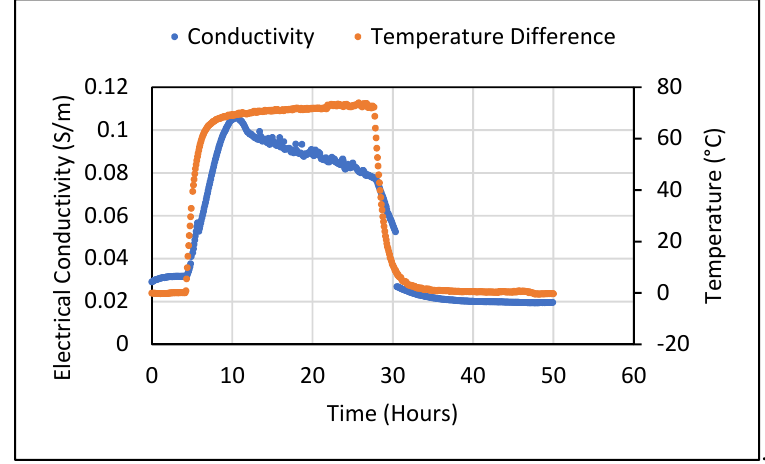
Figure 16. Electrical conductivity at elevated temperature for 5 wt.% Fe 2 O 3 cement composite.